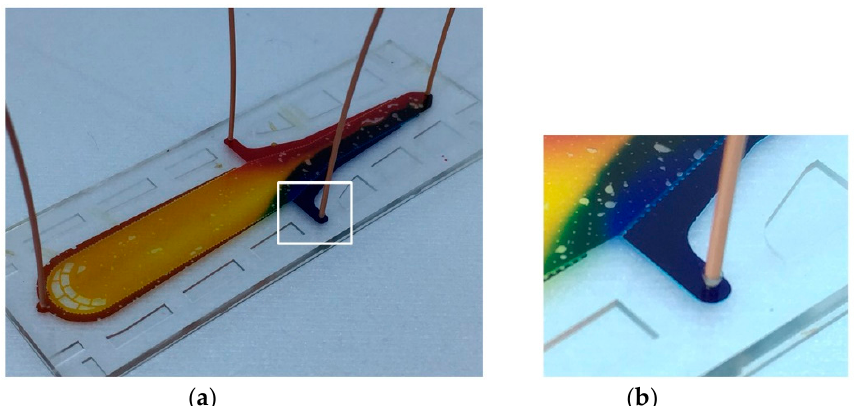
Figure 8. The microfluidic device connected with capillaries using the proposed connector-free interconnection technique and a close-up view of one of the interconnection.